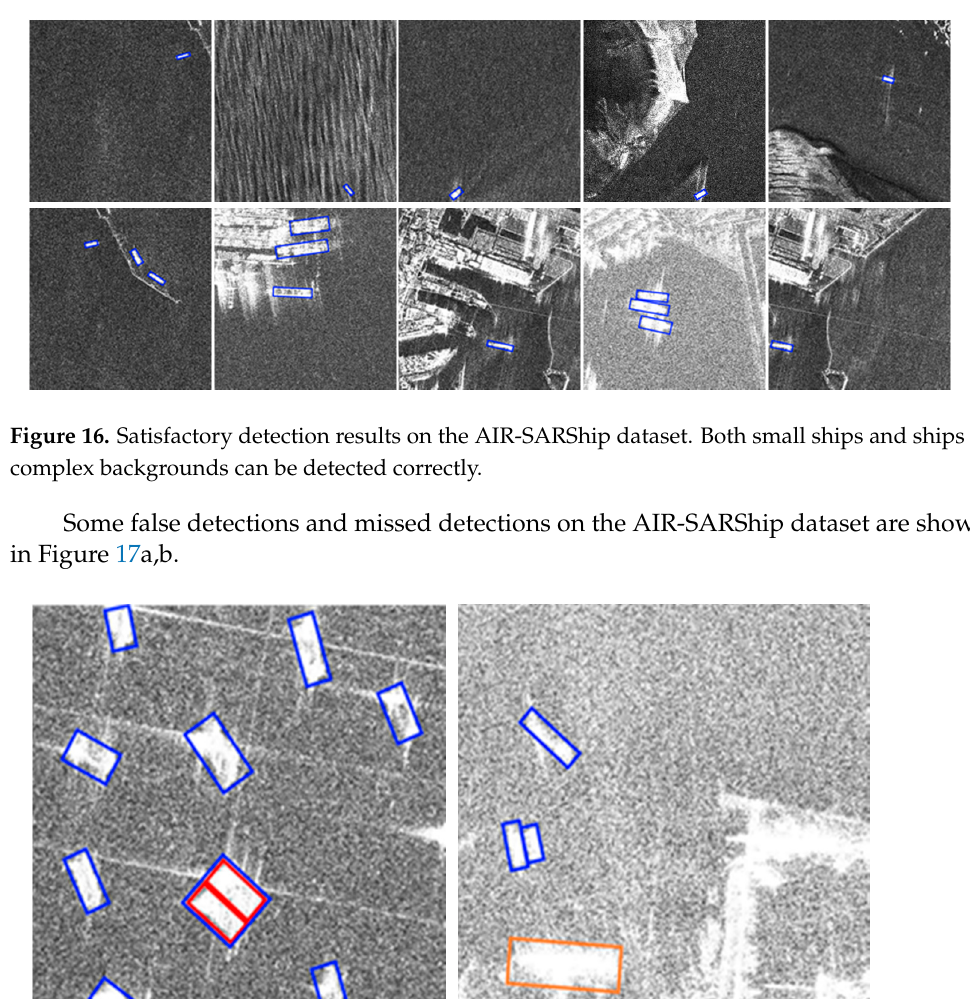
Figure 15. Variation of loss during training on the AIR-SARShip dataset.